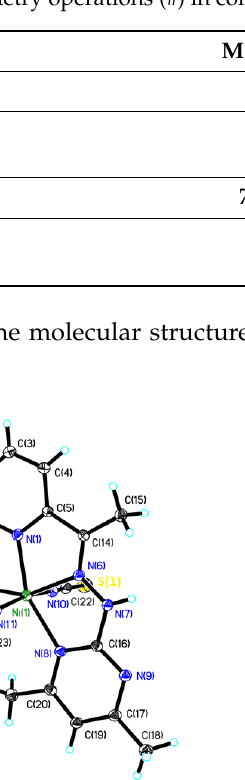
Table 2. Shortest interatomic metal–metal (M … M(1), Å) distances between mononuclear units and